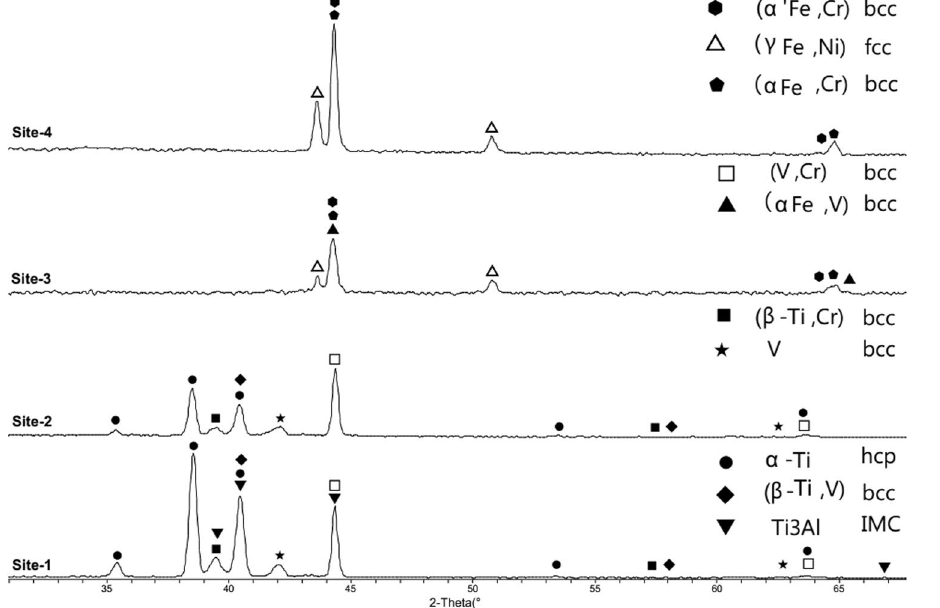
Figure 11. XRD patterns in the four observation